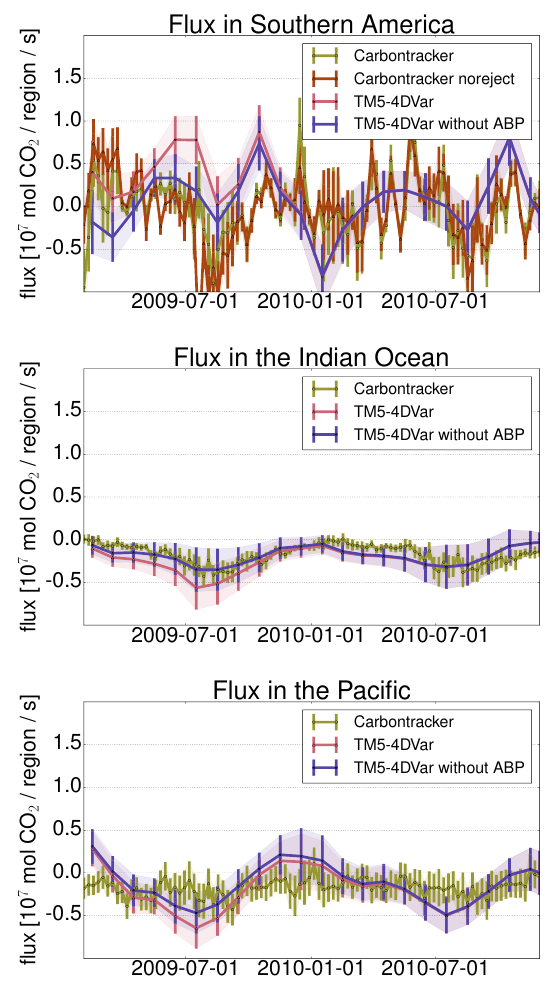
Figure 9. CO 2 surface fluxes from April 2009 to April 2010 in South America and the Indian and Pacific oceans. Only the time se- ries for South America shows the CarbonTracker noreject, because it follows the CarbonTracker baseline in the other regions. The un- certainties shown for CarbonTracker are aggregated spatially but not temporally. See the caption of Fig. 7 for details.